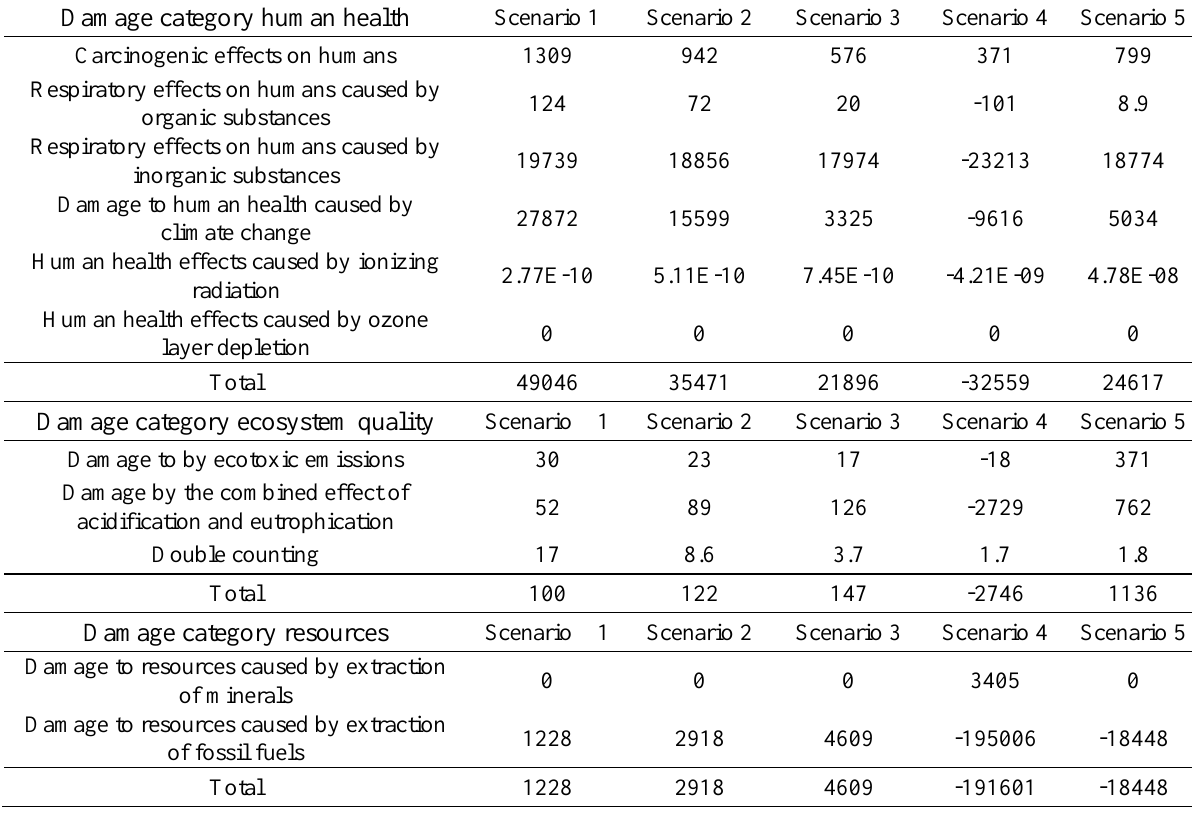
Table 5. Impact assessment results for the scenarios Damage category human